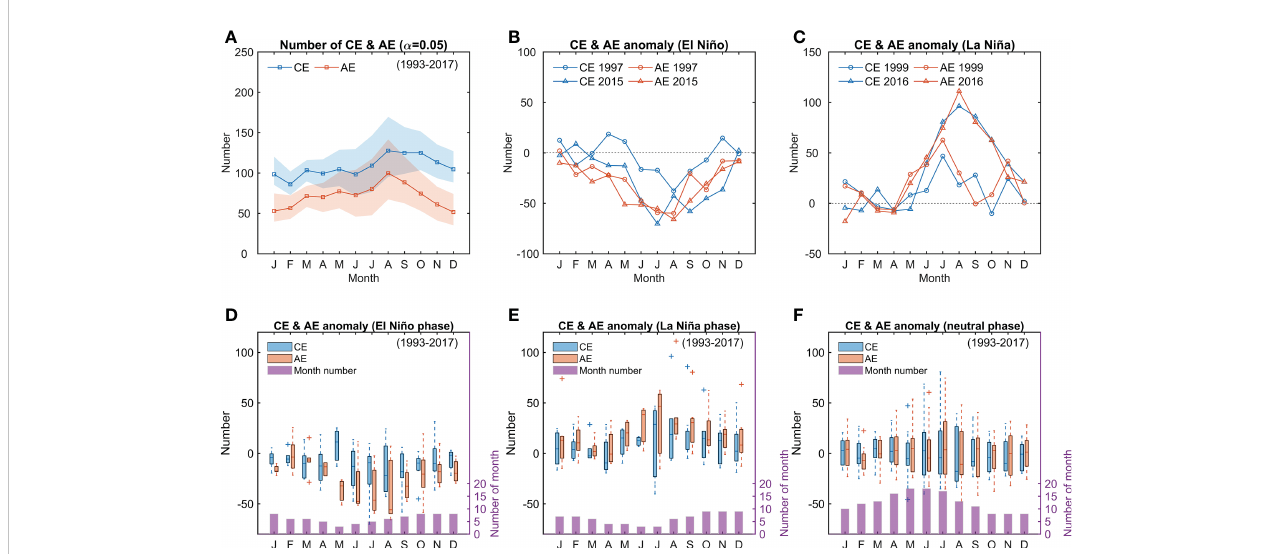
FIGURE 5 Monthly generated number of MEs. (A) The average value and 95% con fi dence interval of CEs and AEs (signi fi cance level ( a ) of 0.05); (B, C) the anomalies of the number of MEs during strong El Niño (1997 and 2015) and La Niña (1999 and 2016) phases; (D – F) the multi-year averaged anomalies of the number of MEs and the number of month during El Niño, La Niña and neutral phases (right axis); the vertical dashed lines indicate the distribution range of the normal value of this set of data, the plus markers are classi fi ed as outliers, the shaded bars indicate the interquartile range, and the black lines in the bars are the median